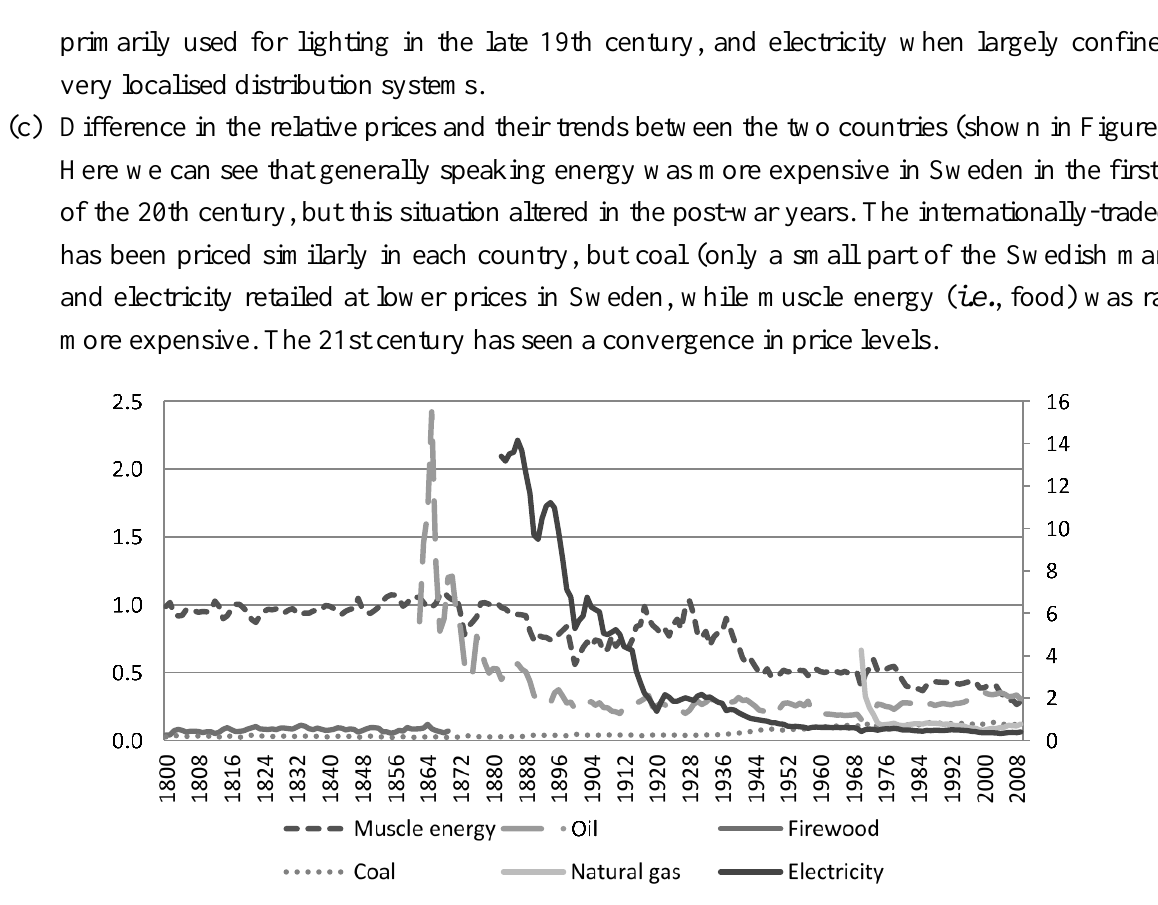
Figure 13. Development of prices in Britain (mln£/PJ, constant prices with the price level 1900), electricity price on the right axis.